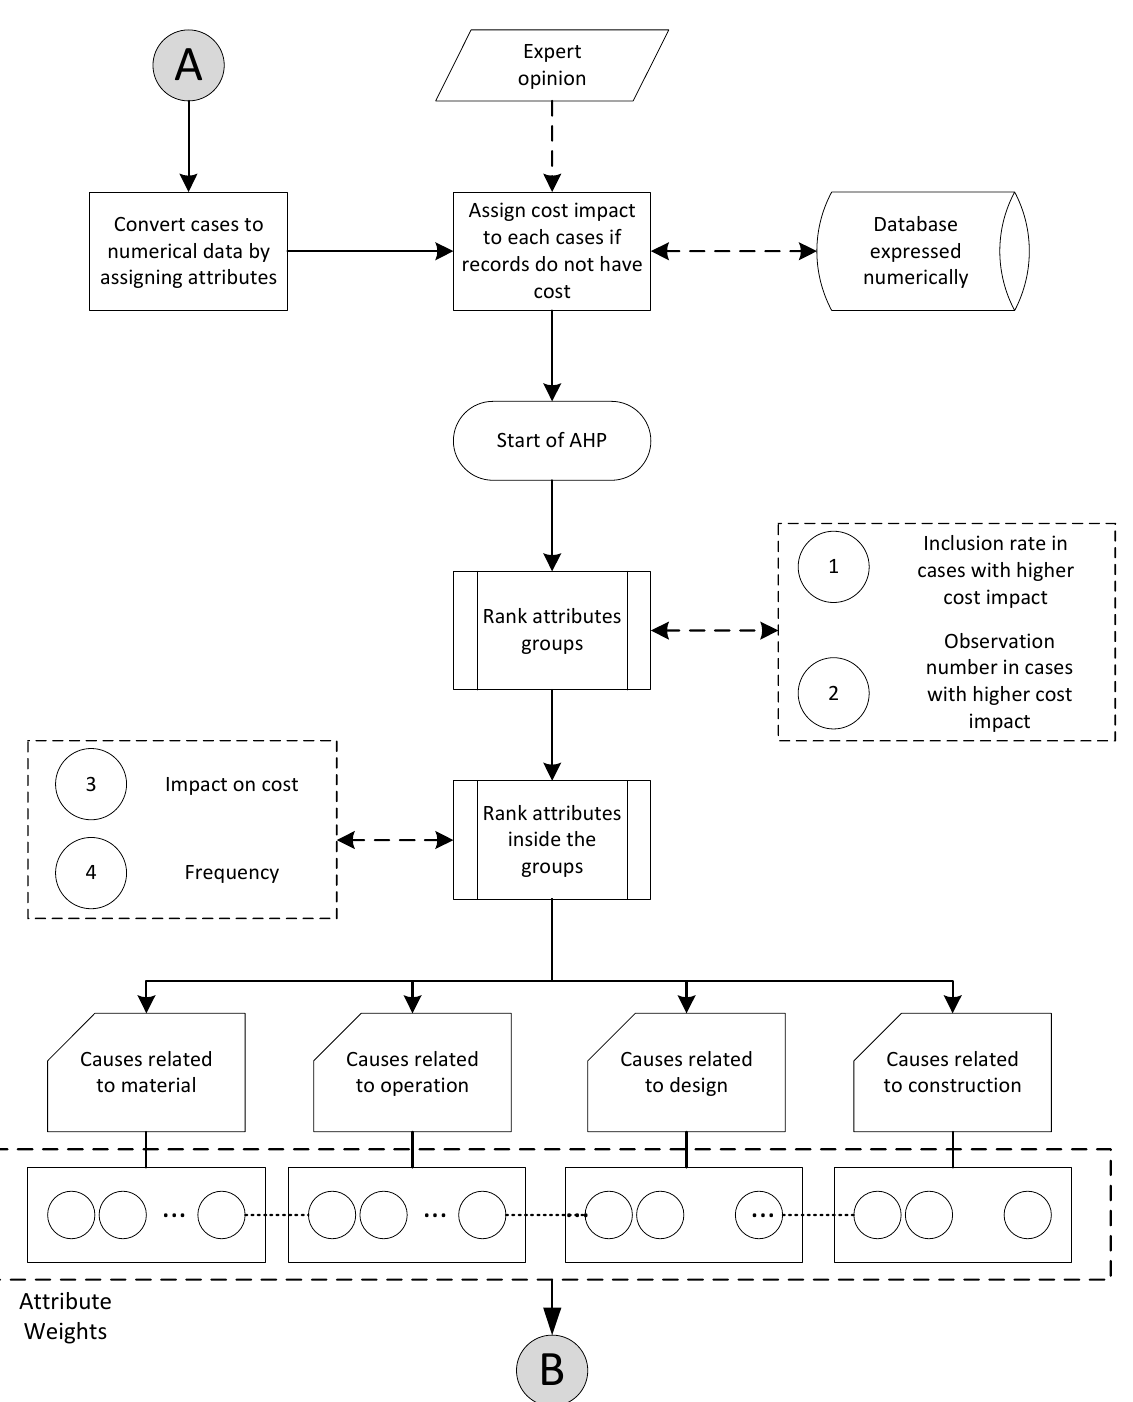
Figure 3. Weight calculation by AHP